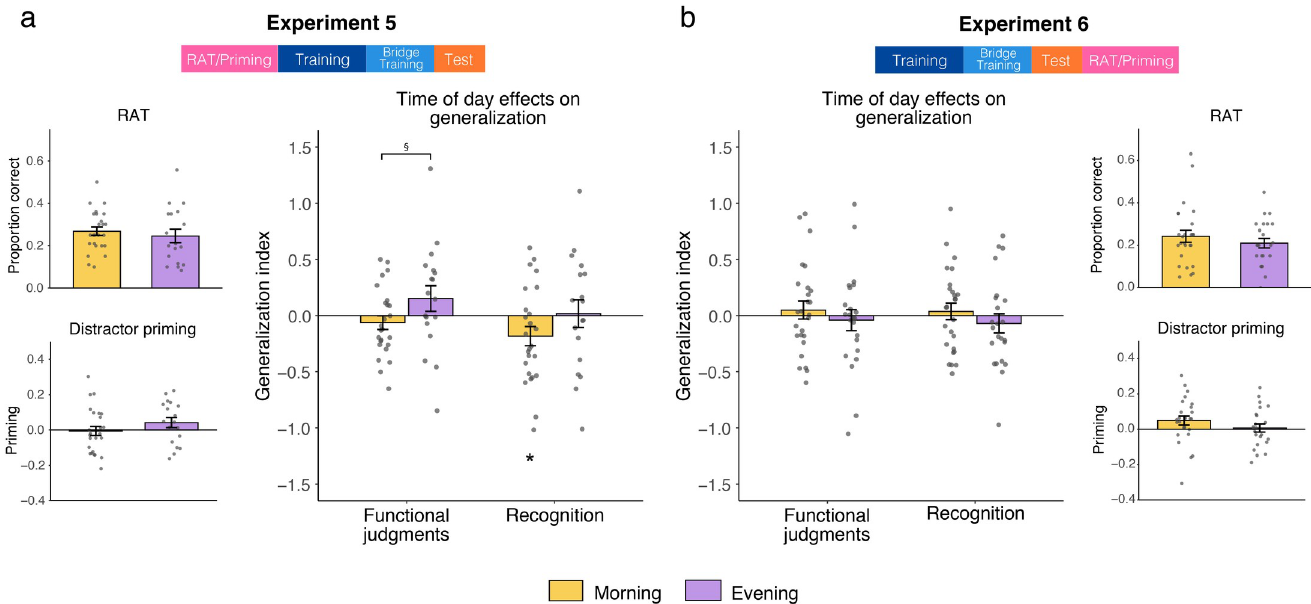
Fig 4. Time of day effects on RAT, distractor priming, and generalization with a simplified category structure. Results for three tasks in (a) Experiment 5 and (b) Experiment 6, with different task orderings as indicated in the top schematics. � p < .05, § p < .1.